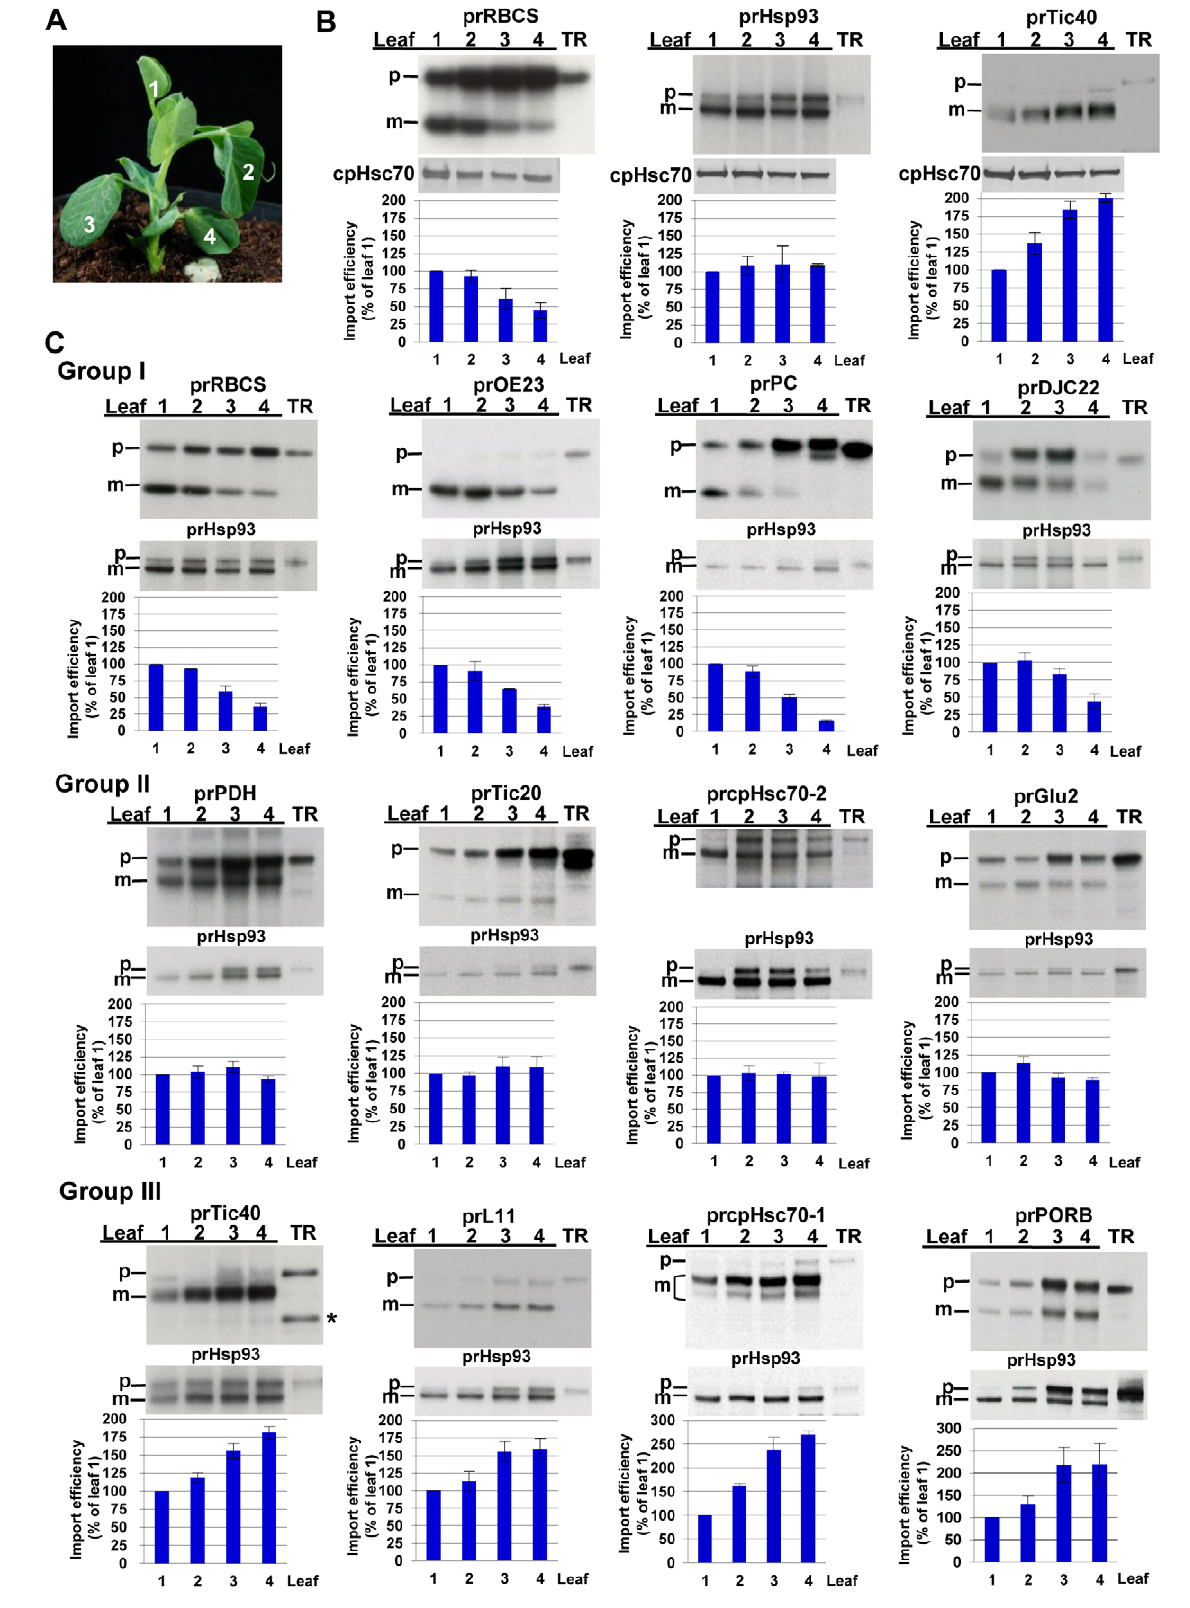
Figure 1. Chloroplast precursors are divided into three age-selective groups. (A) 16- to 18-d-old pea seedlings with four leaves and the youngest leaf still folded were used for chloroplast isolation. Leaf number designation is as labeled. (B) prRBCS, prHsp93, and prTic40 have different